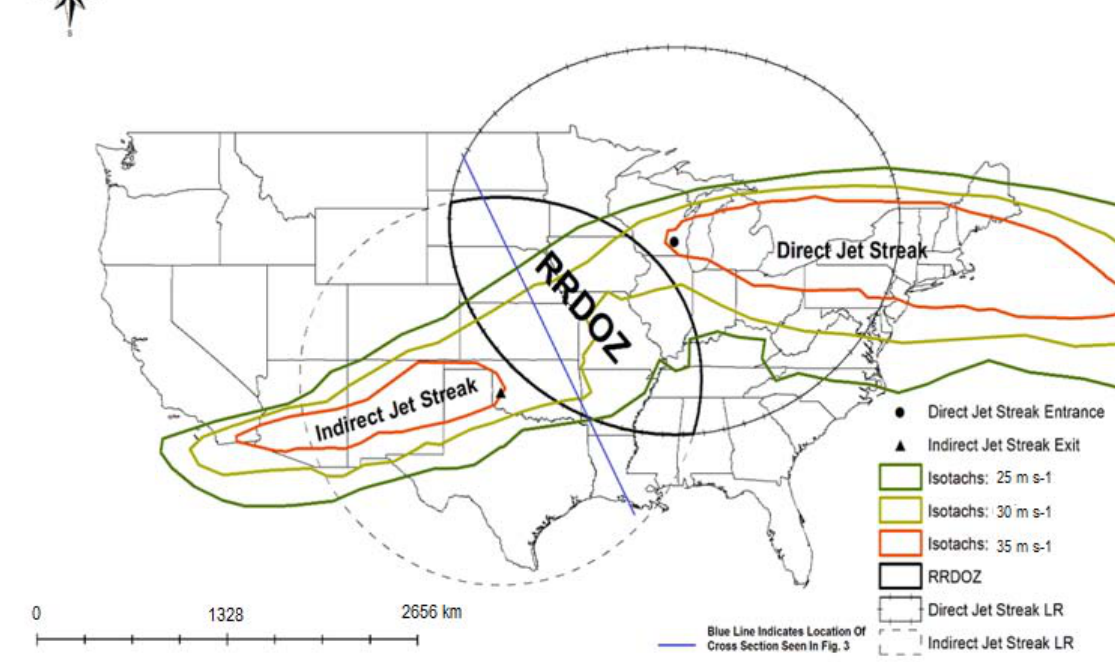
Figure 2. Example of Rossby Radius of Deformation Overlap Zone (RRDOZ) region as a result of intersecting L R buffers around the entrance (direct buffer black circle with vertical ticks) and exit (indirect buffer black dashed circle) regions of the potentially coupled jet streaks at 250 hPa. Green isotachs are 25 m · s − 1 (50 knots), gold isotachs are 30 m · s − 1 (60 knots), and red isotachs are 35 m · s − 1 (70 knots). The solid circle represents the center of the direct jet streak Rossby radius of deformation buffer, while the black solid triangle represents the center of the indirect jet streak Rossby radius of deformation buffer. The solid blue line from North Dakota to the Gulf Coast of Louisiana is a cross section line. This case occurred on 27 January 2009 (Case 38 see Appendix